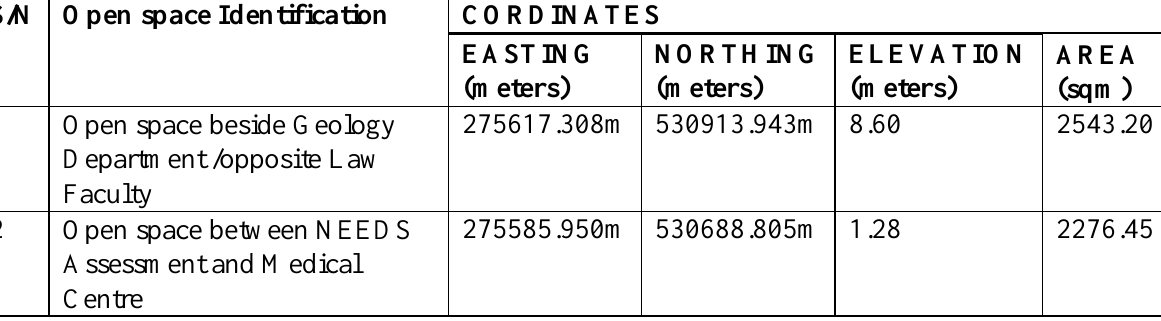
Table 1: Location and sizes of Open Spaces in Zone (A)